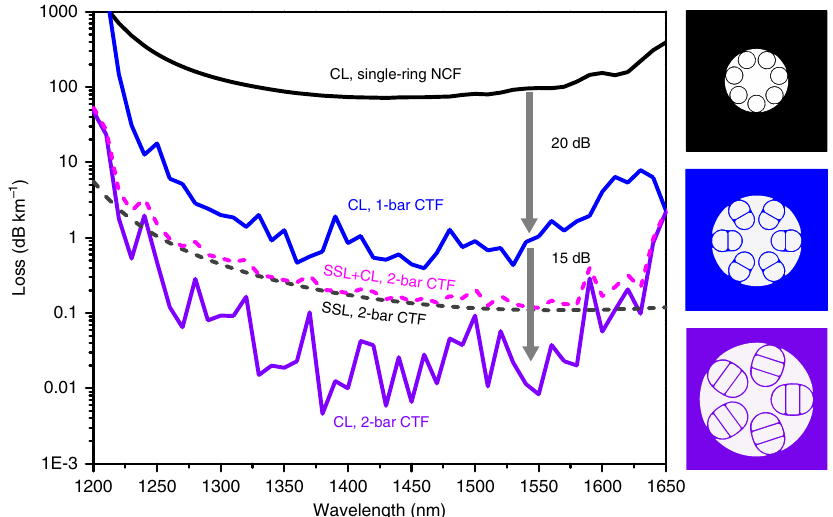
Fig. 4 Comparison of simulated loss spectra of several designs. Schematic illustrations of the single-ring NCF, 1-bar CTF and 2-bar CTF are shown in the right column in black, blue and purple, respectively. They share the same inscribed core diameter of 30.5 µ m. The physical dimensions for each dielectric layers from inward to outward are, t = 1.12 µ m, d = 17.5 µ m (same effective index with S 1 in CTF, see Supplementary Note 3) for the single-ring NCF; t = 1.12 µ m, S = 270 µ m 2 , t = 1.06 µ m, S = 335 µ m 2 for 1-bar CTF; t = 1.12 µ m, S = 381 µ m 2 , t = 1.06 µ m, S = 564 µ m 2 , t = 1.06 µ m, S = 381 µ m 2 for 1 1 2 2 1 1 2 2 3 3 2-bar CTF. The CLs are plotted in solid curves. The SSL and the total loss are plotted in dashed curves. Average reductions of 20 dB from the